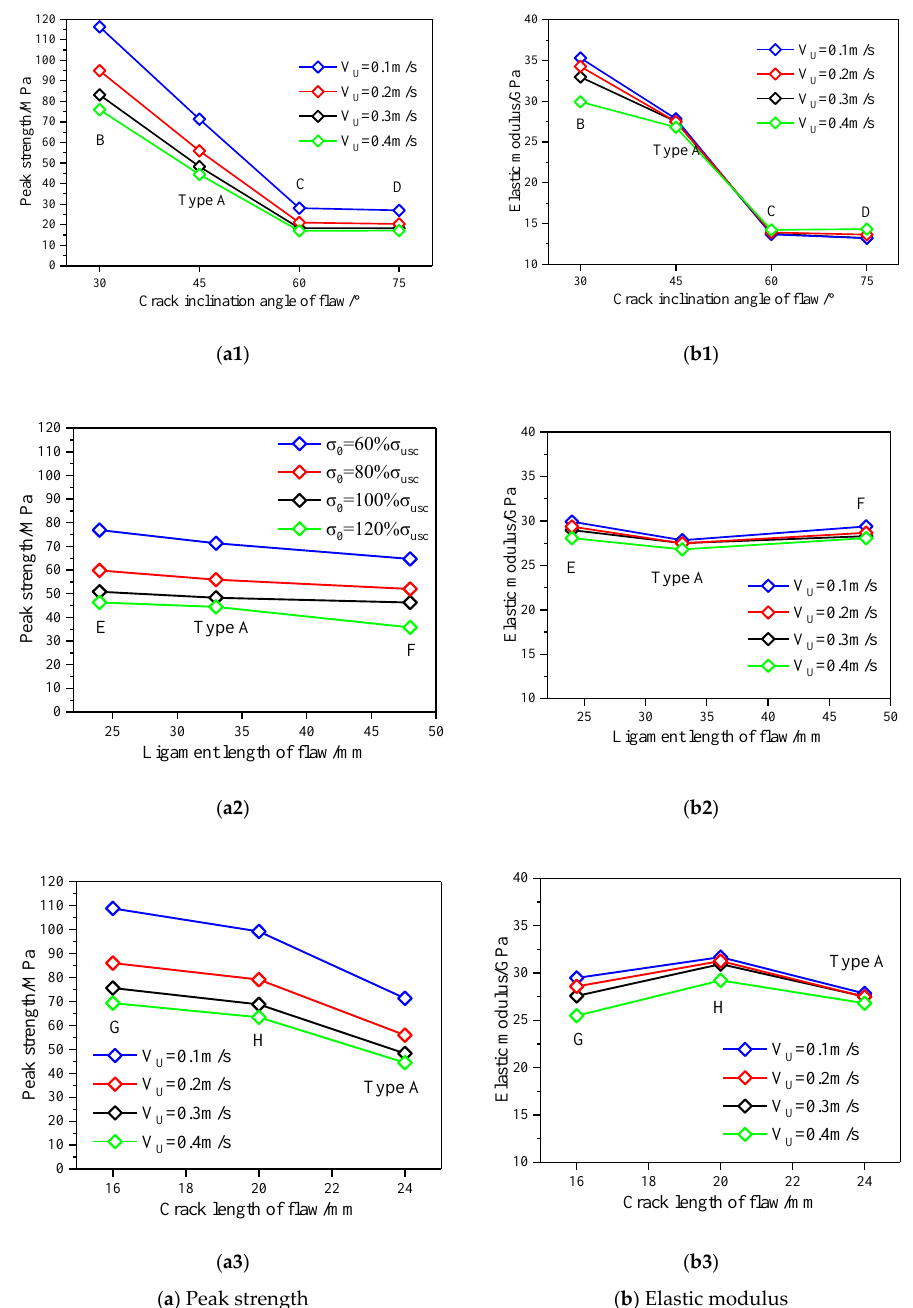
Figure 21. Effect of unloading rate of confining pressures on the peak strength and elastic modulus of marble.